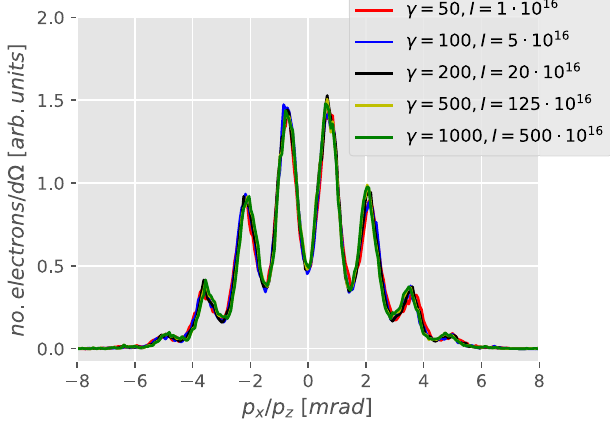
FIG. 5. Transverse momentum space of electron beams with different γ e ( σ x 0 ¼ 2 mrad, σ z ¼ 2 μ m, σ x ¼ 150 nm) after in- teraction. Laser intensity is optimized for maximum modulation depth.